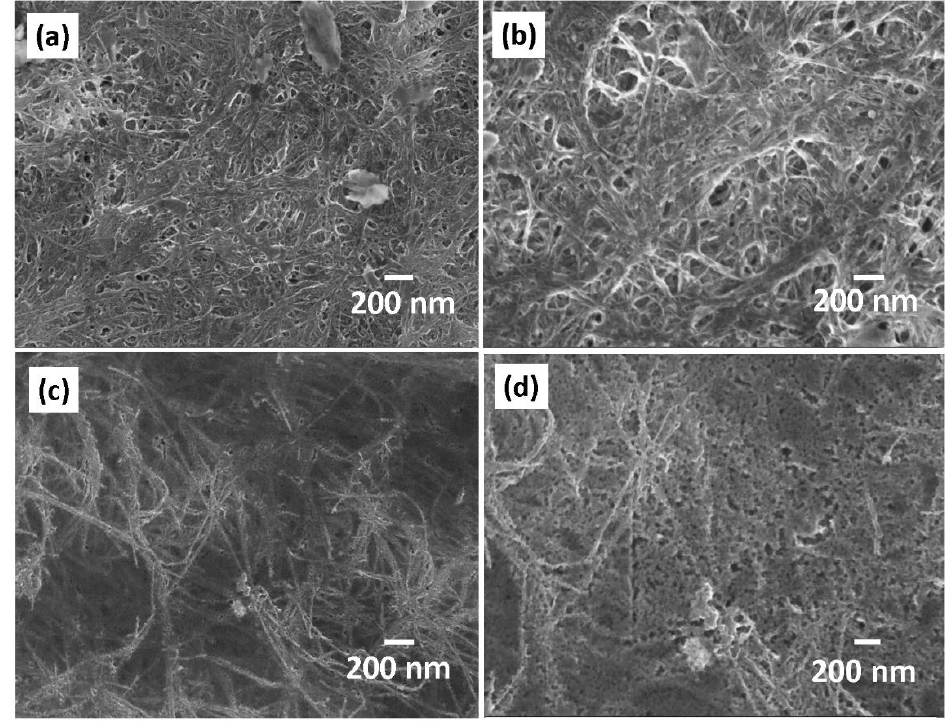
Figure 5. SEM images of a pre-lithiated CNT after 1 min ( a , b ) and pre-lithiated CNT after 15 min ( c , d ).